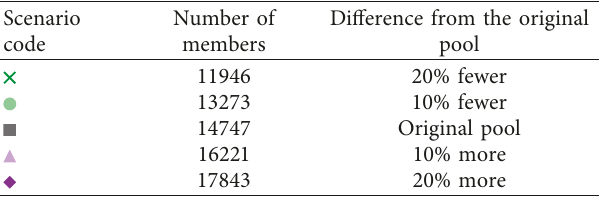
Figure 4: Distribution of the synthetic population and Oply members. Table 3: Scenarios definition for demand variation.